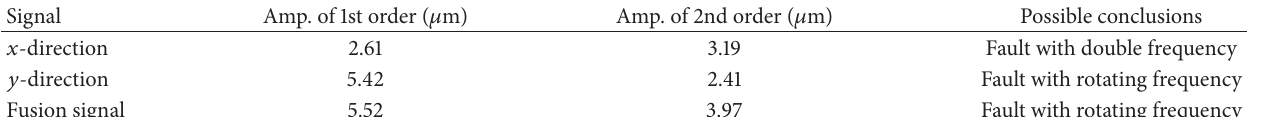
Table 1: Difference of the 𝑥 -direction and 𝑦 -direction and fusion signals.